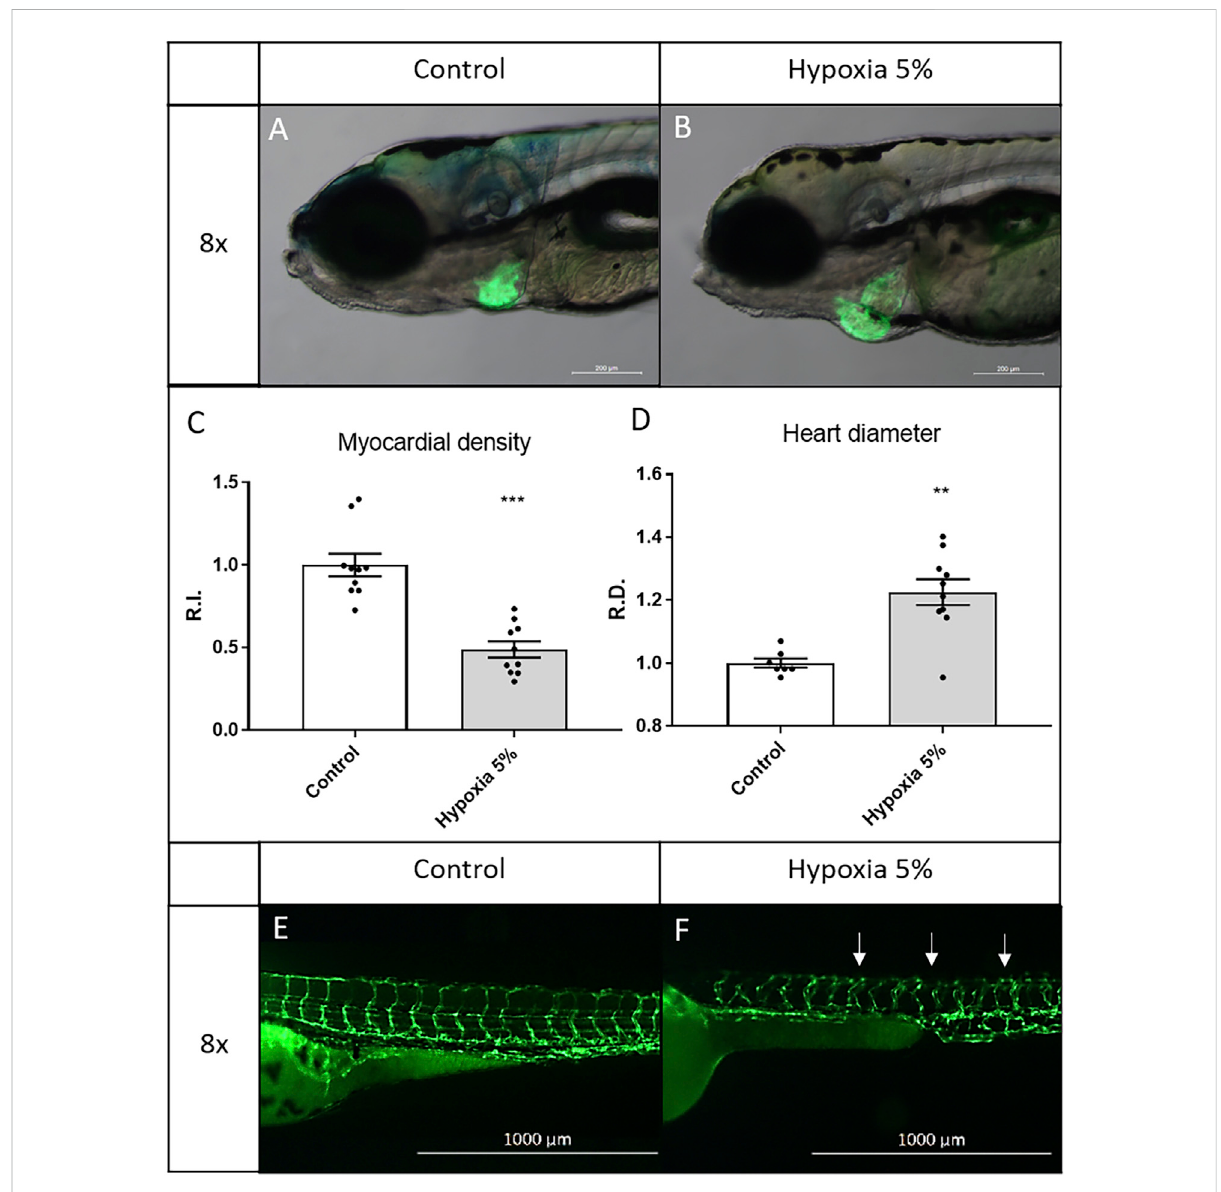
FIGURE 3 Long-term hypoxia induces cardiovascular modi fi cations in zebra fi sh embryos/larvae. (A – D) After a 5-days incubation in 5% hypoxia, 6-dpf zebra fi sh larvae display enlarged heart and in fl ated myocardial layer, as evidenced by the fl uorescence of the myocardial transgene Tg(tg:EGFP- myl7:EGFP) ia300 . (E,F) After a 2-days incubation in 5% hypoxia, 3-dpf zebra fi sh embryos display disorganized intersegmental vessels (arrows), identi fi edbytheendothelialtransgene Tg( fl i1:EGFP) y1 .6-dpflarvaeand3-dpfembryosareinlateralview,anteriortotheleft.Samplesize: n